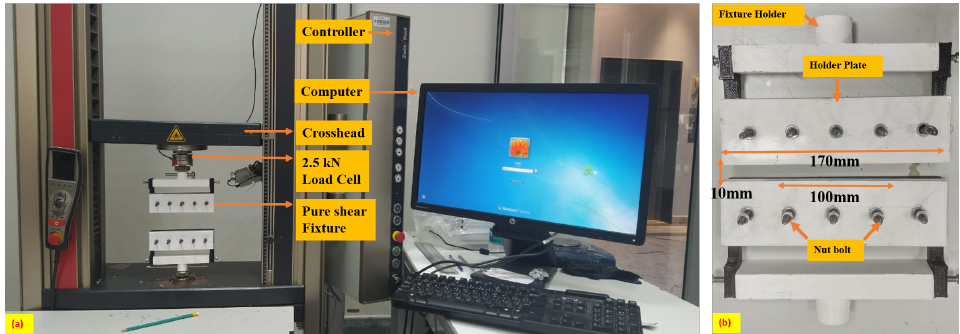
Figure 1. Details of ( a ) UTM (Zwick Roell) and experimental setup used for pure shear and uniaxial fracture experiments. ( b ) Enlarged view of laboratory made 3D printed fixture used for fracture